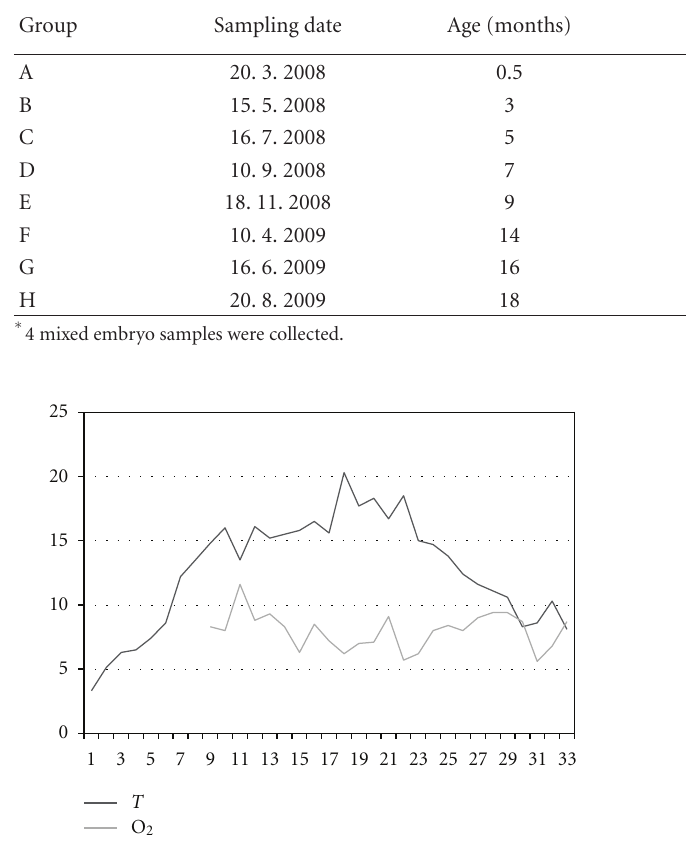
Figure 1: Water temperature ( ◦ C) and oxygen concentration (mg · l − 1 ) in 2008 (weeks 1–33).